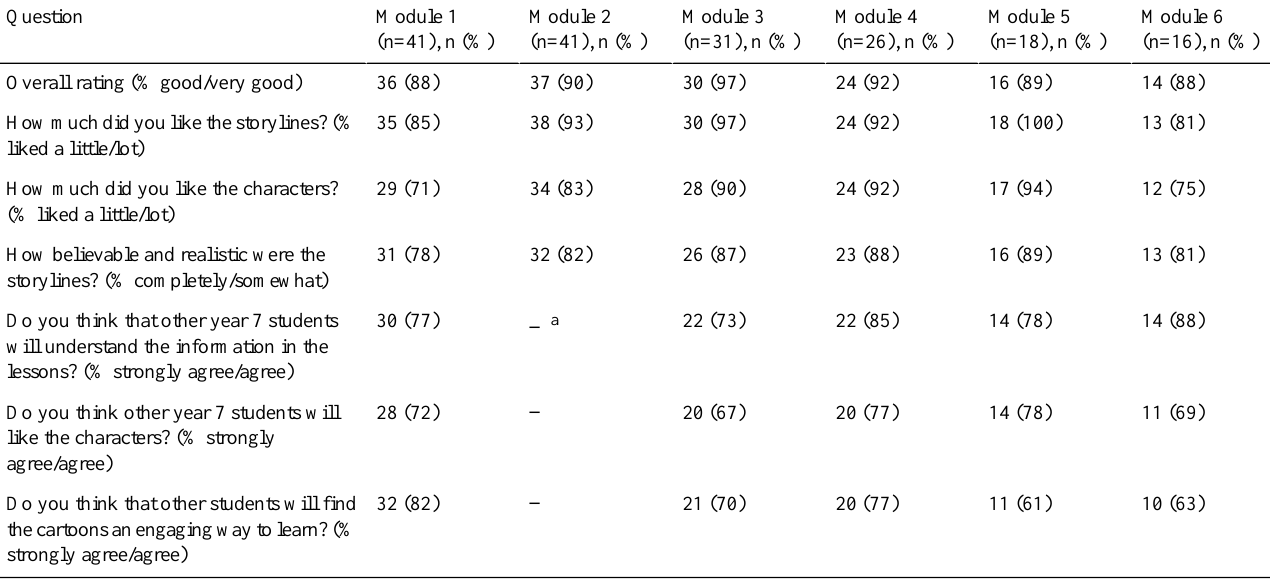
Table 5. Summary of student questionnaire